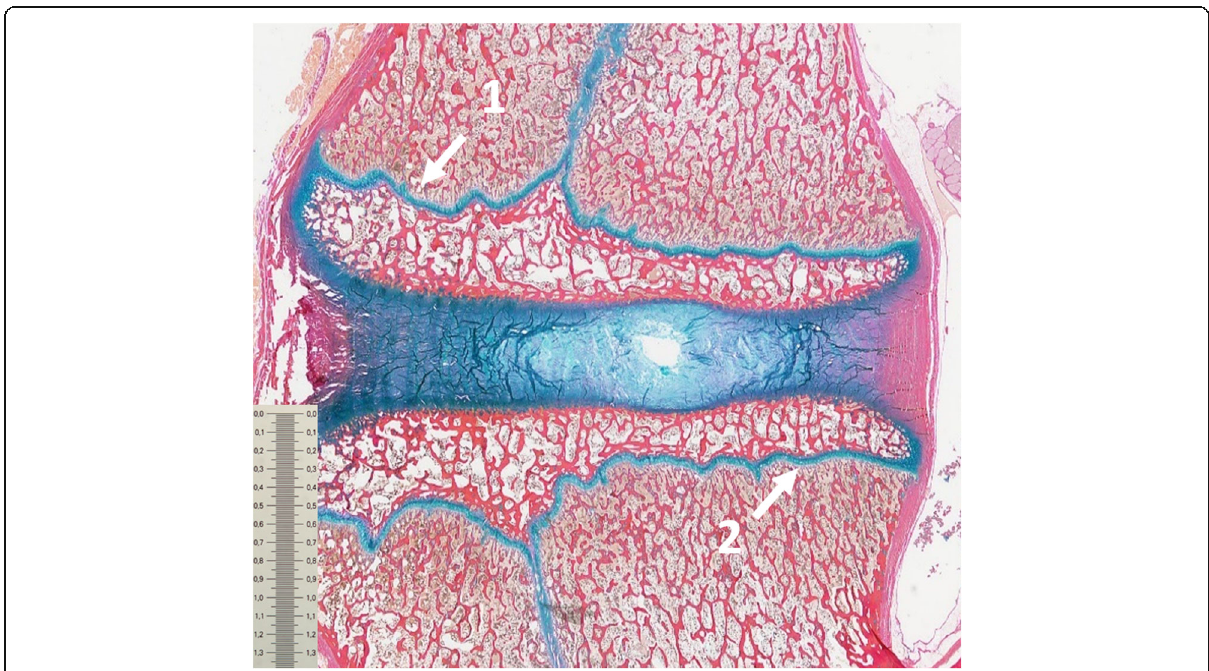
Fig. 4 Histological overview of a flexed FSU. Highlighted are the cranial-anterior growth zone (1) and the caudal-posterior growth zone (2). Sizebar in cm. Haematoxylin-eosin and Alcian blue solution stain